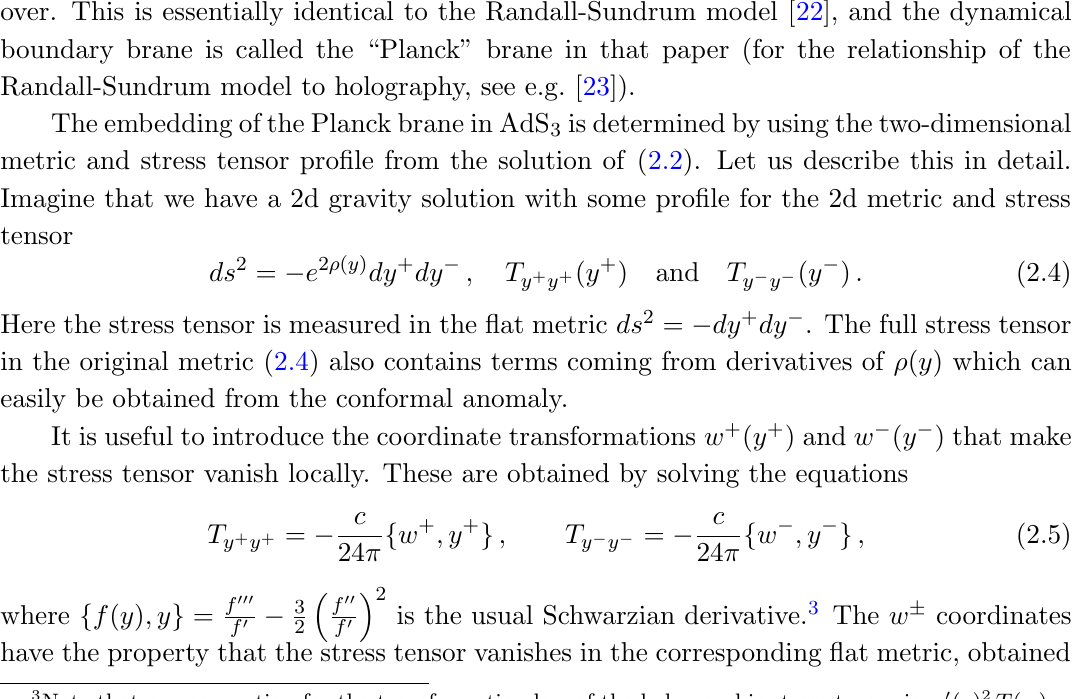
Figure 1 . On the left, we have a 2d dilaton-gravity theory coupled to a matter CFT of the matter CFT 2 are denoted collectively by (cid:31) , and this CFT 2 is assumed to be holographic. On the right, we display a 3d geometry obtained by replacing the matter CFT 2 with its 3d dual. This is a version of the Randall-Sundrum setup [22, 23]. On the 2d boundary of this 3d geometry, we have the dilaton-gravity action. The boundary (cid:12)elds (cid:30) and g (2) functional